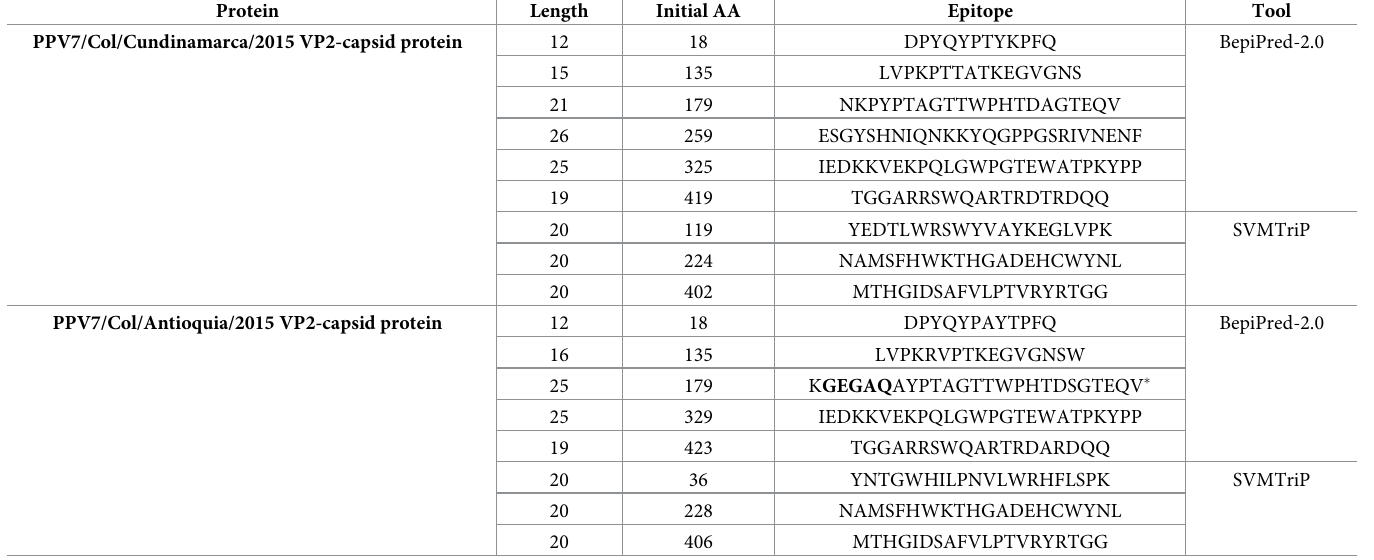
Table 3. Predicted B cell epitopes from Colombian PPV7-VP2 capsid protein with and without insertion. Protein